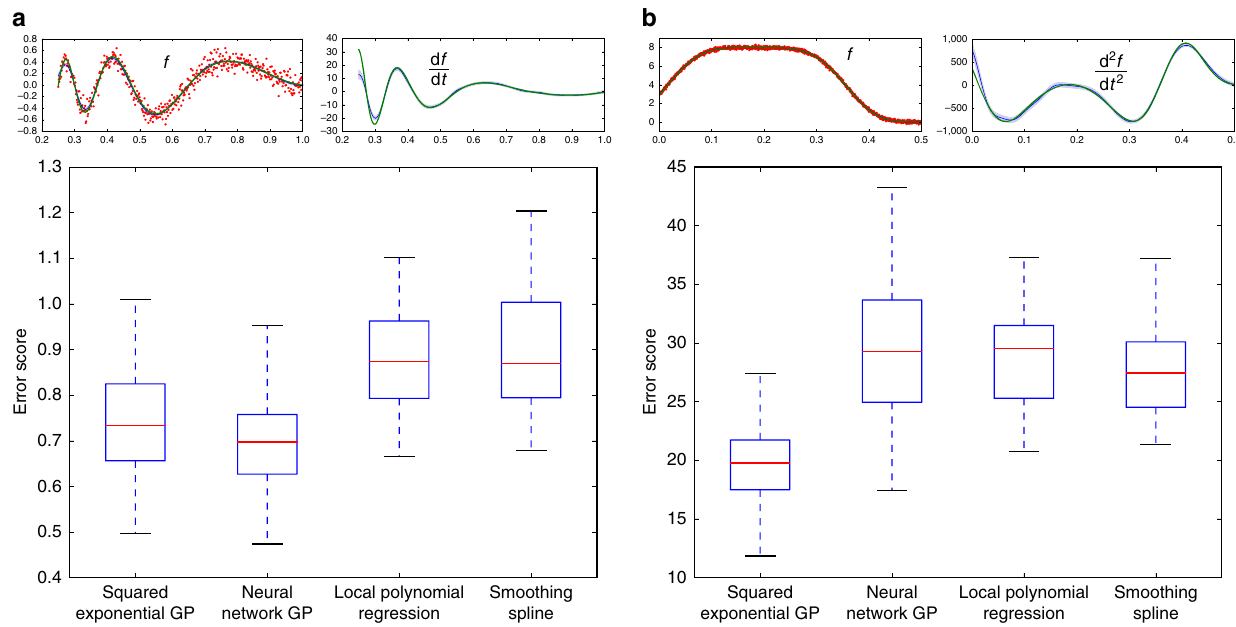
Figure 2 | The inference method can perform better than alternatives. ( a ) Inference of the first derivative. A box plot of error scores (related to the mean absolute difference between the inferred and exact derivative) for inference of the first derivative. We use either a squared exponential covariance function or a neural network covariance function for the Gaussian process (GP) and compare with local polynomial regression (with p ¼ 3) and a quintic penalized smoothing spline (data for both from ref. 8). Top left shows one sample data set (in red with 500 data points), the true underlying function (in green) and the inferred latent function using a neural network covariance function—the best fit (in blue); top right shows the corresponding first derivative (with here an error score of 0.64): exact (in green) and inferred (in blue). Equivalent plots for the alternative inference methods are given by De Brabanter et al. 8